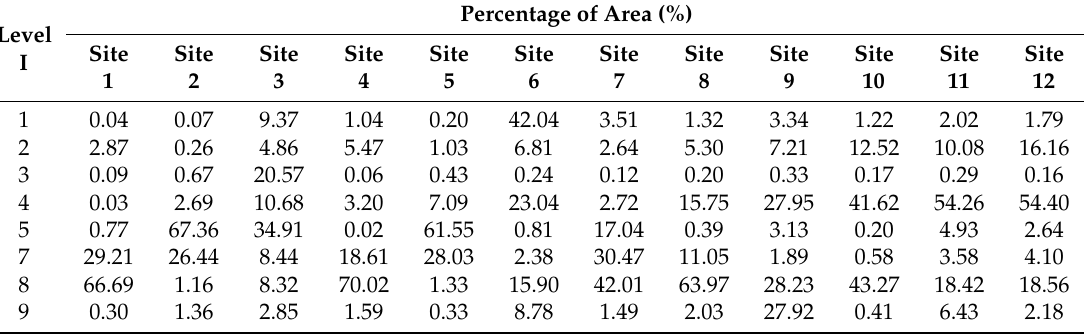
Table 6. Percentage of each thematic class for twelve study sites using level I classification scheme (8